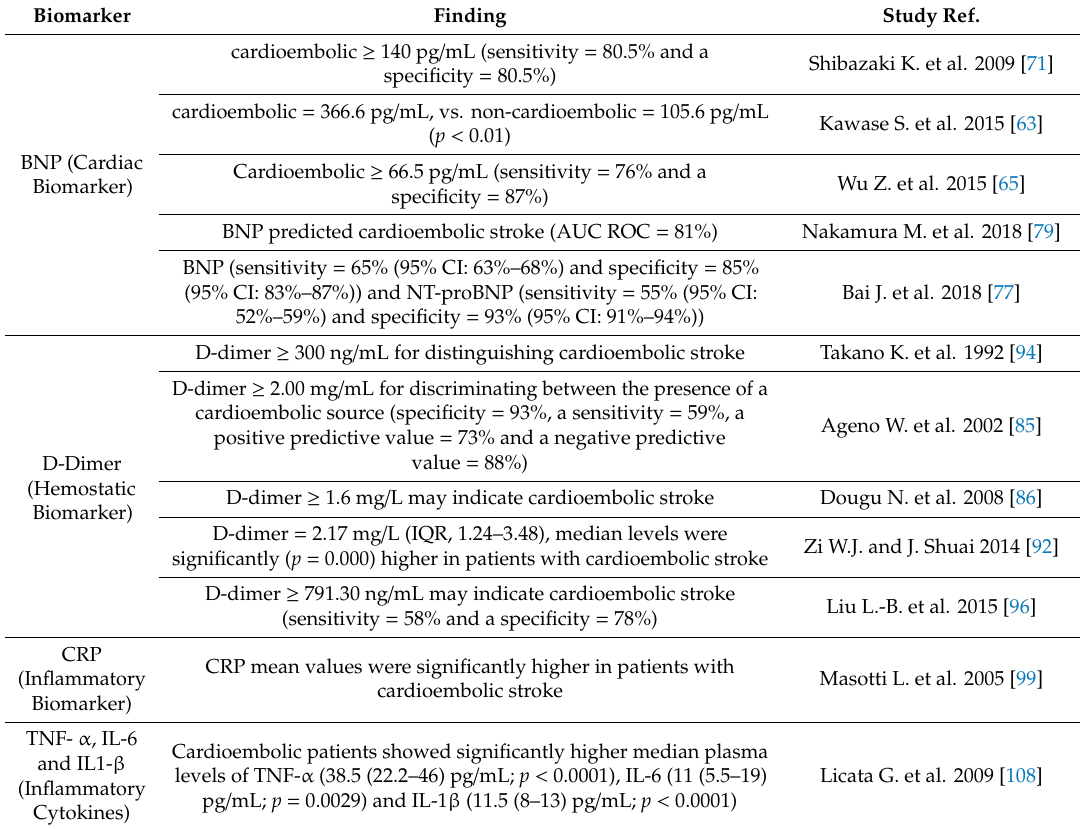
Table 2. Blood-based biomarkers that best indicate cardioembolic etiology. Biomarker Finding Study